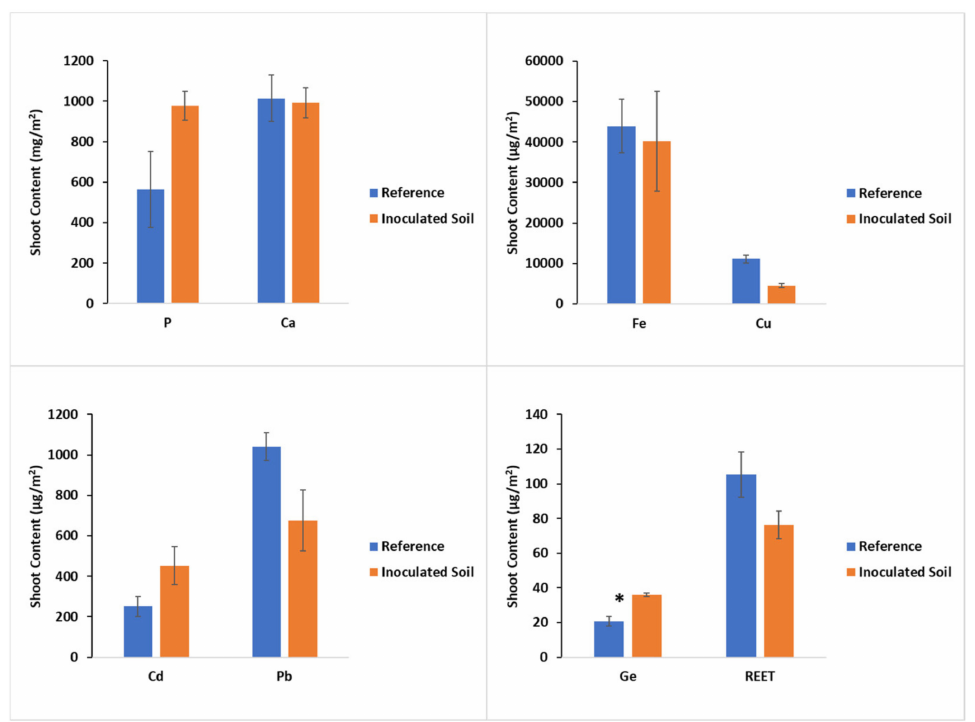
Figure 3. Effect of soil inoculation on element accumulation in above-ground biomass of Zea mays . Significant difference ( p ≤ 0.05) between means indicated by asterisks * (mean ± SE, n = 3). Table 3. Concentration ( µ g/g) of elements in shoots and roots. Mean ± SE, n = 3–4, NIL = reference, R = inoculated Soil. Statistics a means asymptotically distributed F statistic for Welch’s ANOVA. A = Zea mays . B = Helianthus annuus . SC = shoot concentration. RC = root concentration. vs. = compared